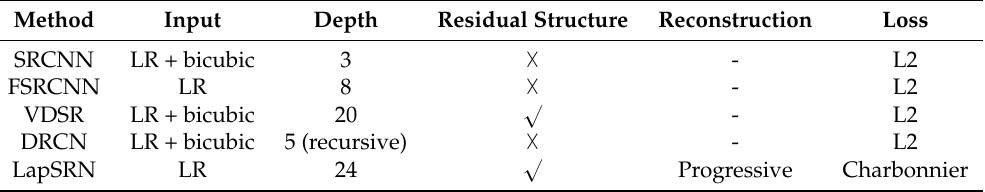
Table 1. Comparison of CNN-based SR methods: SRCNN, FSRCNN, VDSR, DRCN, and LapSRN. Method Input Depth Residual Structure